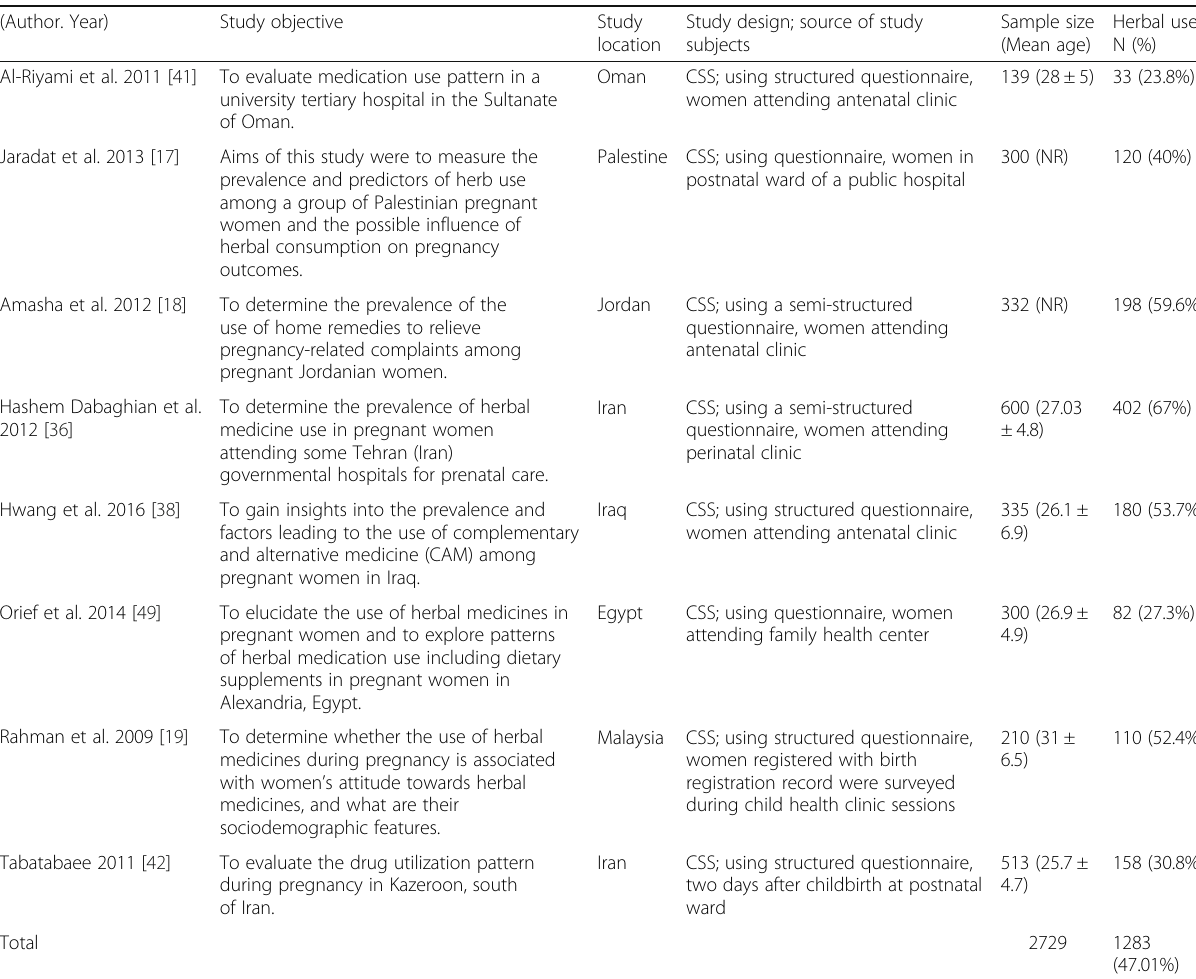
Table 3 Details of studies included in the review (Author.